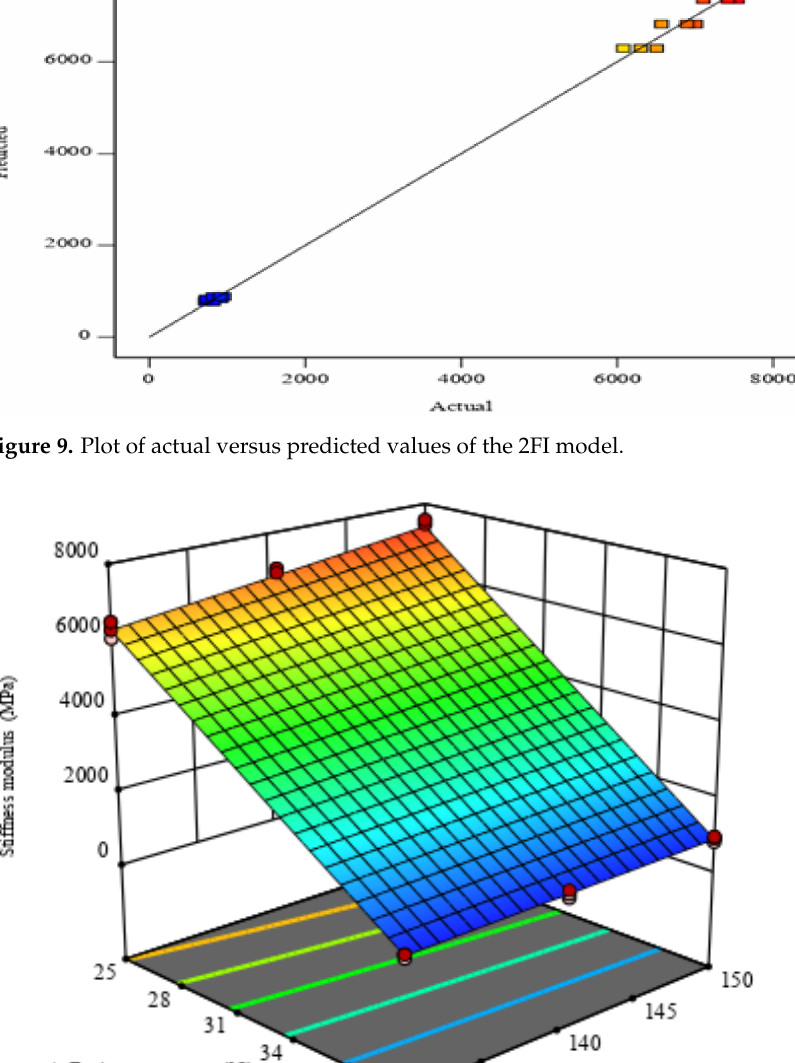
Figure 8. Plot of normality of 2FI model.